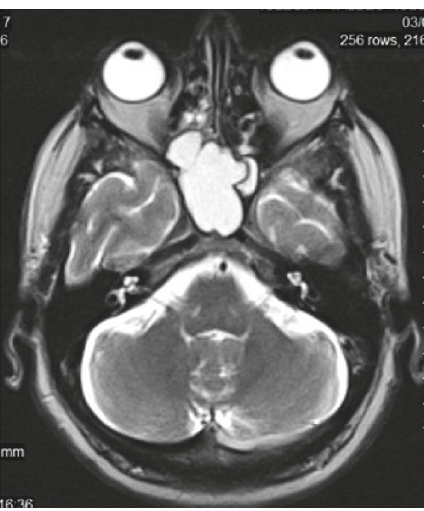
Figure 1: The lesion appearing hyperintense on T2-weighted RMI.